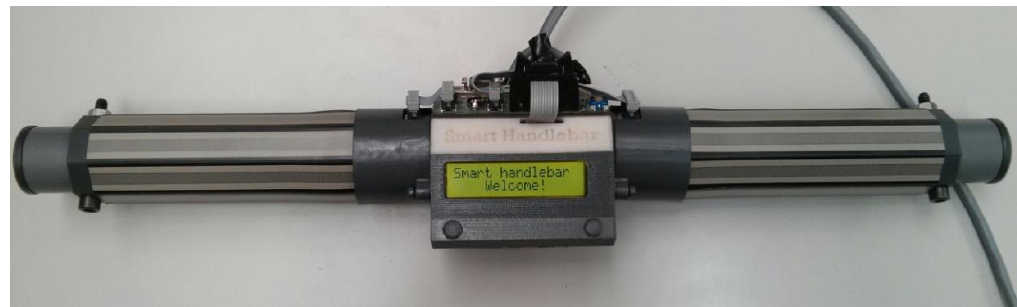
Figure 4. Second prototype of the proposed